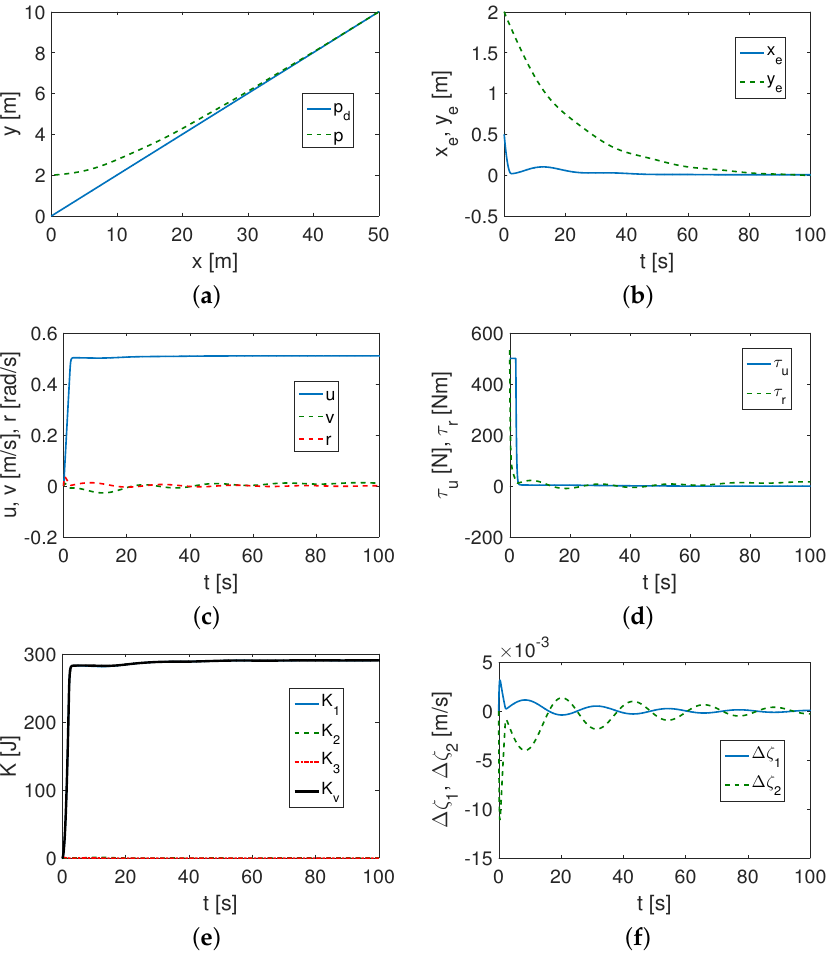
Figure 4. Results for the SIRENE, QV controller and linear trajectory: ( a ) desired and realized trajectory; ( b ) position errors; ( c ) velocity errors; ( d ) applied force and torque; ( e ) kinetic energy time history; ( f ) quasi-velocity errors ∆ ζ 1 , ∆ ζ 2